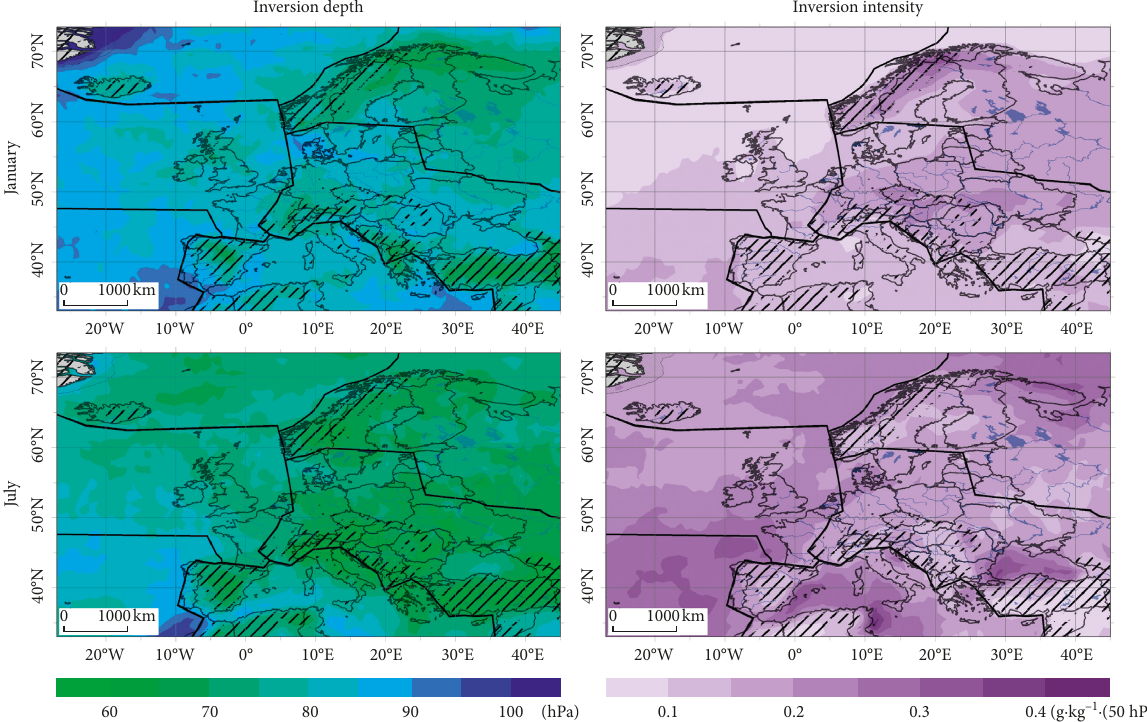
1 1 ) (1981–2015); slanted lines are used to denote areas situated kg (50hPa) · · − −